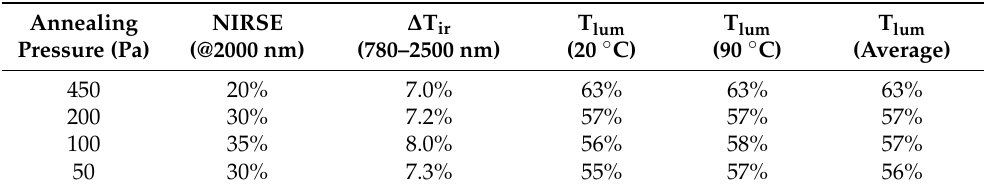
Table 5. Optical properties of thin VO 2 films prepared by 30 nm V metal films at different anneal- ing pressures.